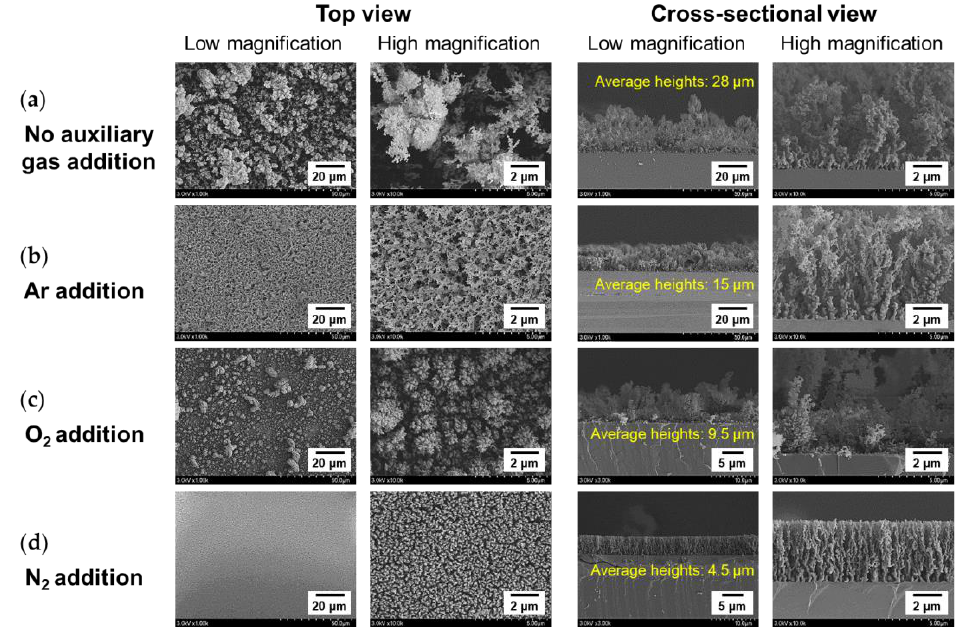
Figure 5. FE-SEM images of PANI films deposited on silicon substrates and polymerized ( a ) without auxiliary gas, ( b ) with the addition of Ar, ( c ) O 2 , and ( d ) N 2 .